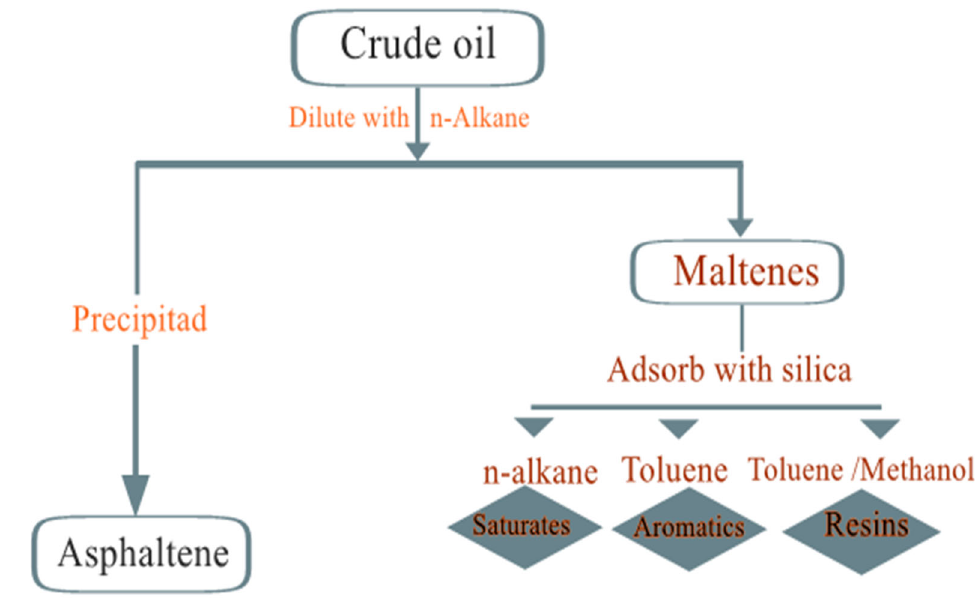
Figure 8. Schematics of the SARA fractionation.